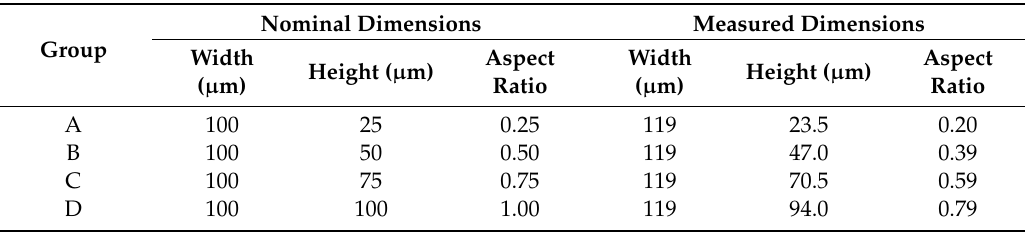
Table 8. Characterization of microfeatures’ dimensions on 3D printed tooling inserts and comparison with nominal design dimensions.